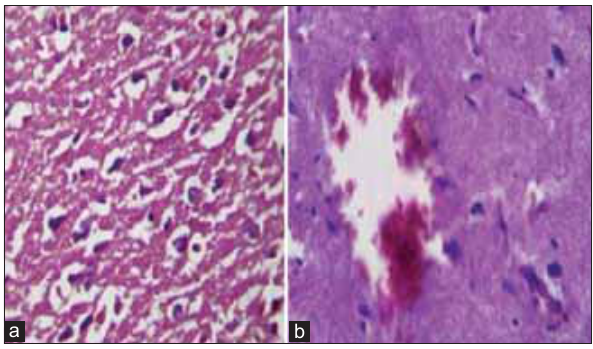
Figure-6: (a) Neural degeneration in brains of rats of 200 mg/kg group, (b) Mild degenerative changes and hemorrhages in the brain of rats of 100 mg/kg